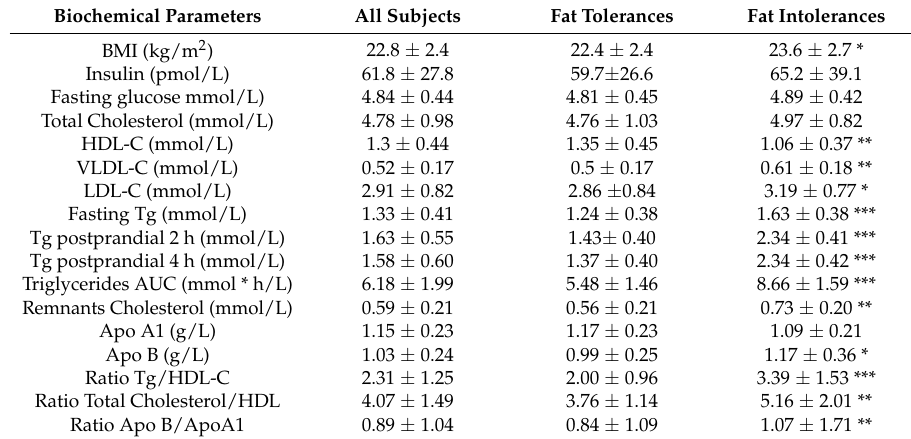
Table 1. Anthropometric and biochemical parameters for all the studied subjects and after their classification into fat tolerant and fat intolerant group.